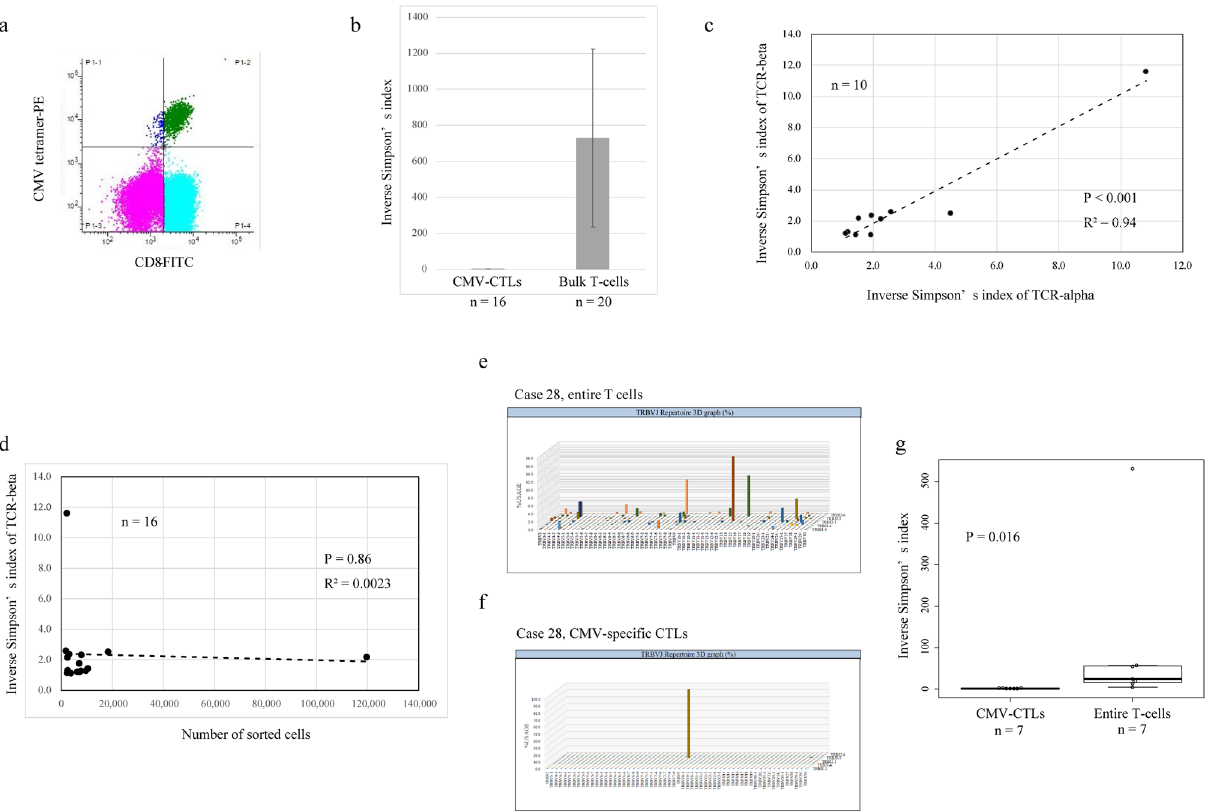
Figure 1. ( a ) Representative image of the gating used for cell sorting. CD8 + /HLA-A*24-specific cytomegalovirus (CMV) pp65 tetramer + cells were sorted (green fraction, upper-right). ( b ) Box-plot representing the diversity of the T-cell receptor (TCR)-beta repertoire of CMV-specific cytotoxic T-cells (CTLs) (left column) and published data on the diversity of TCR-beta repertoire of entire T-cells (right column) 37 . ( c ) Correlation between the diversity of TCR-alpha and -beta in CMV-CTLs. ( d ) Correlation between the diversity of TCR-beta in CMV-CTLs and the number of sorted cells. ( e , f ) A 3D graphical representation of the TCR repertoire in the entire T-cell population and CMV-CTLs. The X and Y axes show TRBV and J segments respectively and the Z axis indicates frequency. ( g ) Box-plot representation of the diversity of the TCR-beta repertoire in CMV-CTLs and the entire T-cell